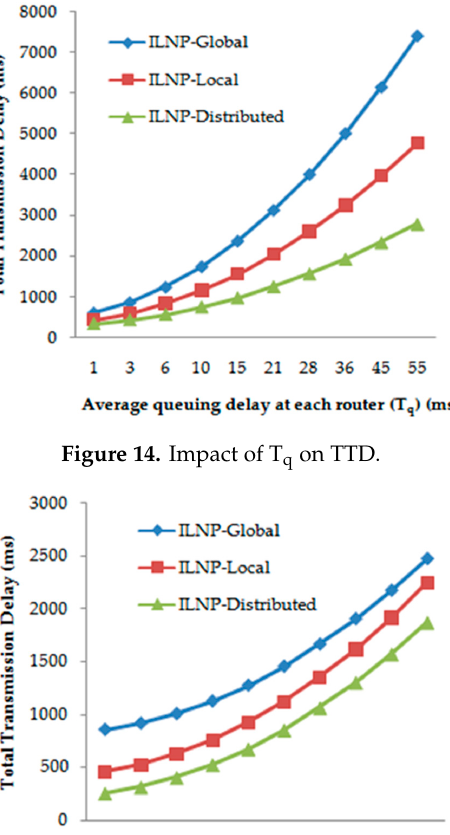
Figure 13. Impact of q on TTD.